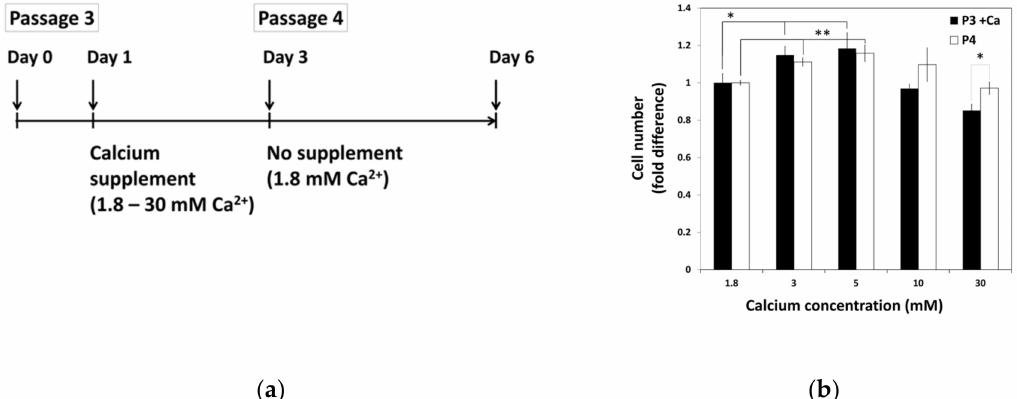
Figure 3. The continuance of hBMSCs proliferation after exposure to moderate-high calcium concentrations. ( a ) The schematic drawing of experiment procedure. hBMSCs were treated with various calcium concentrations for 48 h and sub-cultured to in standard media with normal calcium level. ( b ) Cell growth was evaluated after three days of seeding and compared between passages (P3 + Ca: * 1.8 vs. 3 mM p = 0.0293, * 1.8 vs. 5 mM p = 0.04481, P4: ** 1.8 vs. 3 mM p = 0.0030, ** 1.8 vs. 5 mM p =